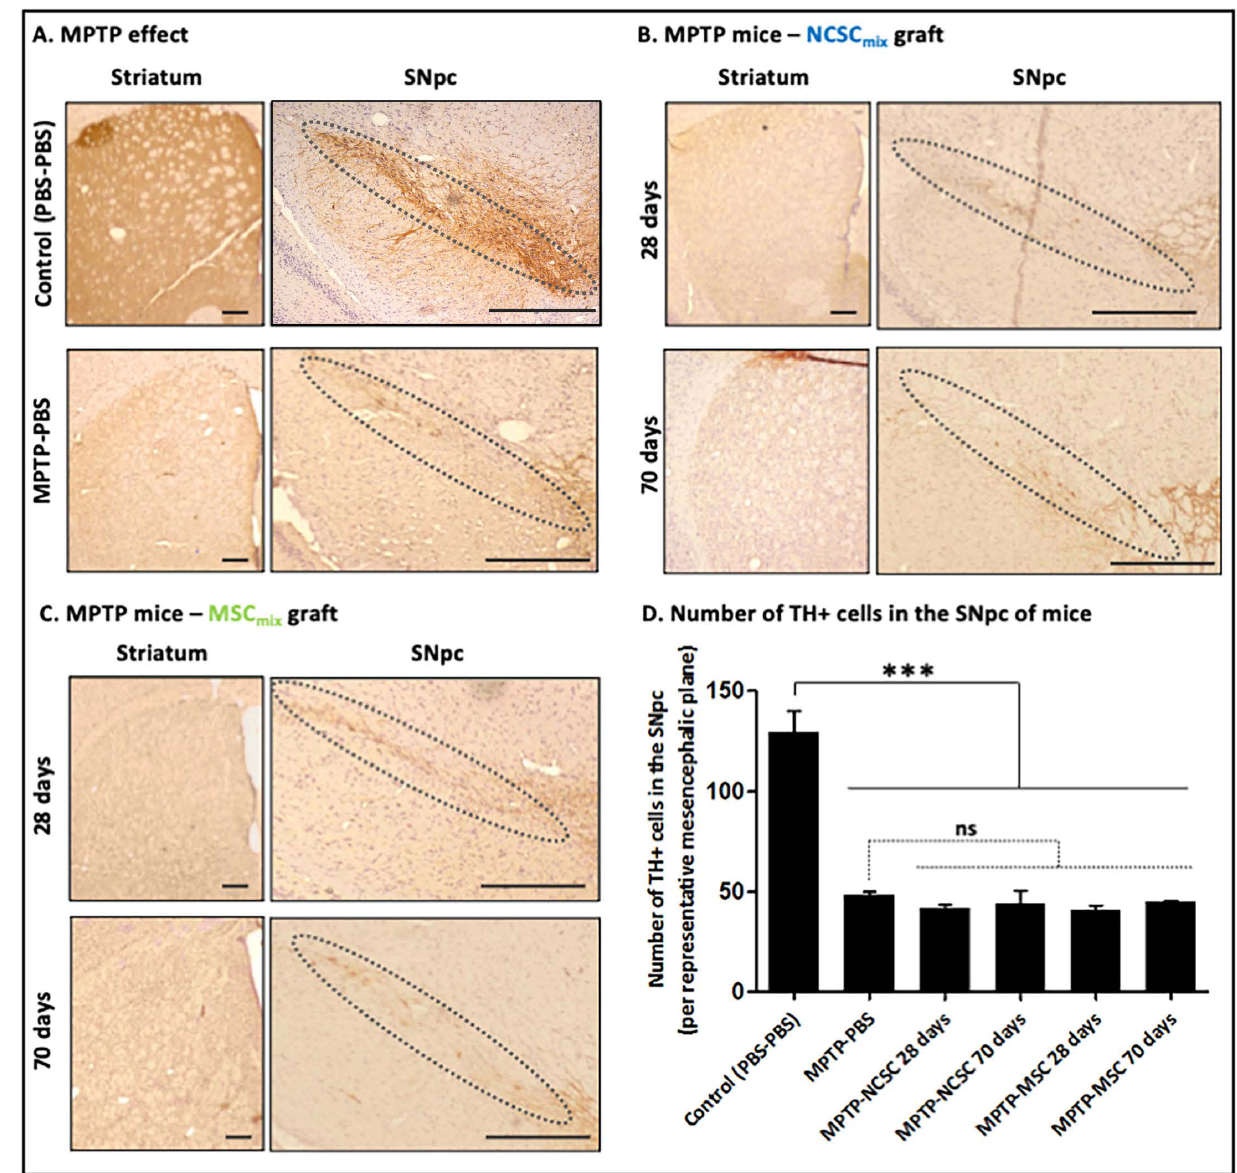
Figure 5. Evaluation of NCSC mix and MSC mix graft consequences on the number of host TH-positive neurons in MPTP-induced dopaminergic lesions. A. Effect of MPTP on the integrity of dopaminergic nigro-striatal pathway (at 28 days post-MPTP treatment). B. NCSC mix graft in MPTP-treated mice. No increase in TH-positive ( brown ) striatal dopaminergic fibers and TH-positive cell bodies in the SNpc is observed, at 28 days as well as 70 days post- NCSC mix transplantation. C. The same observations were carried out after MSC mix transplantation. D. Number of TH- positive cell bodies in the SNpc of MPTP-treated mice that were transplanted with NCSC mix /MSC mix (p . 0,05; Kruskall-Wallis ANOVA). Scale bars=250 m